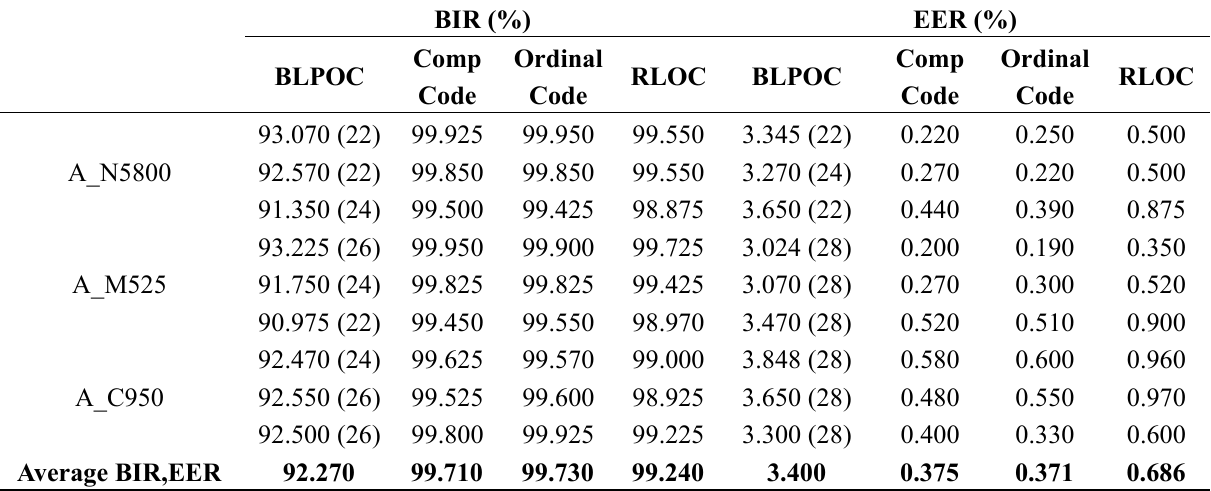
in BLPOC method achieved 1